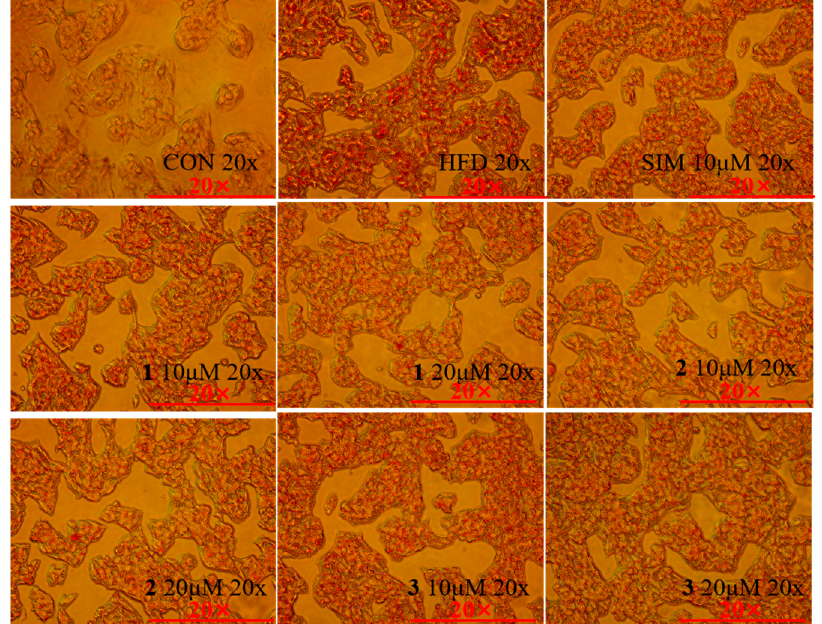
Figure 6. Oil red O of HepG2 cells under 20× mirror. CON: cells without any treatment. HFD: cells treated with high fatty acids alone. SIM 10 μ M: cells treated with high fatty acids and simvastatin 10 μ M. Sets of samples: cells treated with high fatty acids and corresponding sample concentrations.